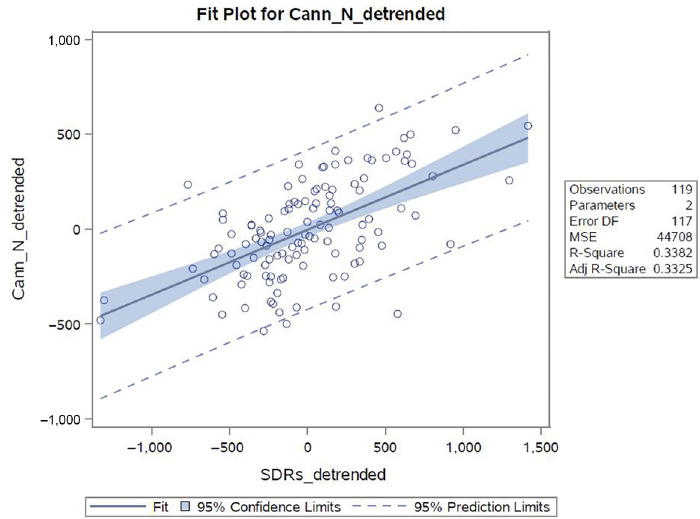
Figure 1. Aggregate Cann regression fi t